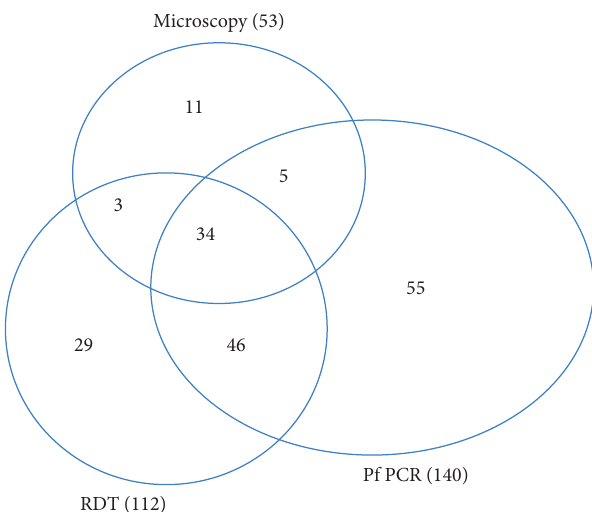
Figure 2: Plasmodium falciparum infection detected by multiple tools. A Venn diagram illustrating the results of P. falciparum identification by nested PCR and an HRP2-based malaria RDT. The number of positive samples identified by each test is listed in parentheses after the test